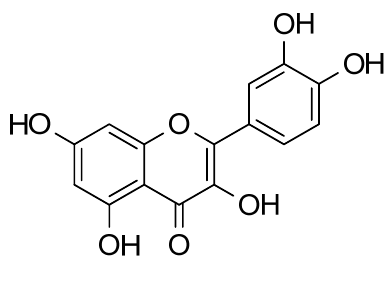
Figure 6. Structure of